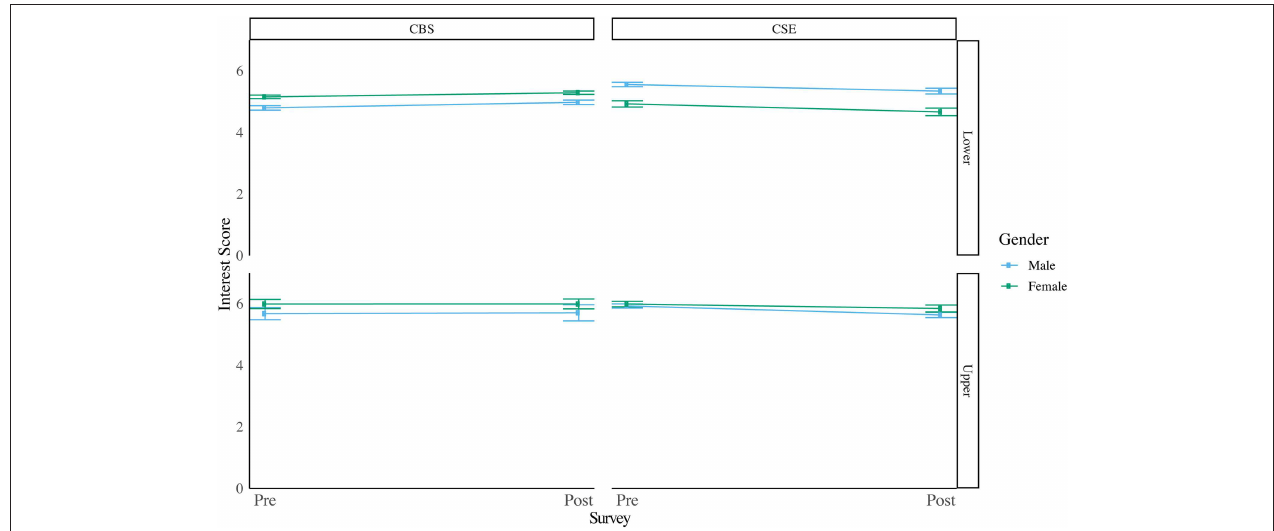
FIGURE 6 | Change in interest in course content over the course of the semester for students in CBS and CSE for women (green) and men (blue) in lower division courses (Top) and upper division courses (Bottom) . The survey was administered at the beginning (pre-survey) and at the end of semester (post-survey).